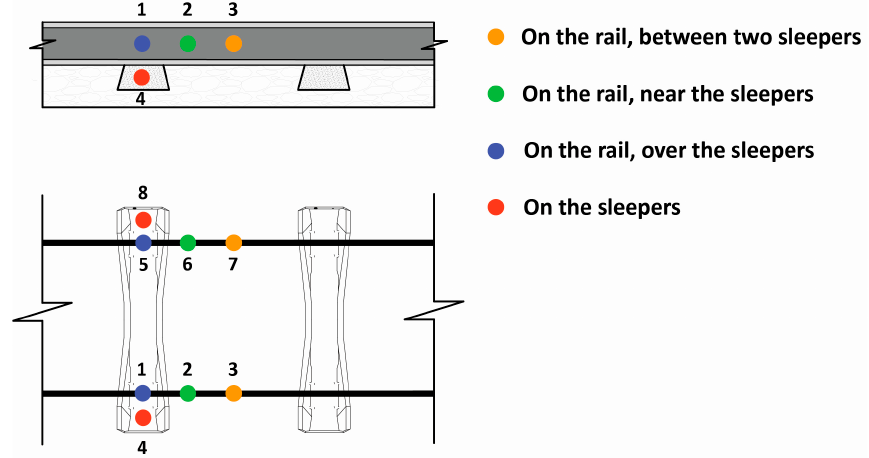
Figure 2. Virtual wayside monitoring system.